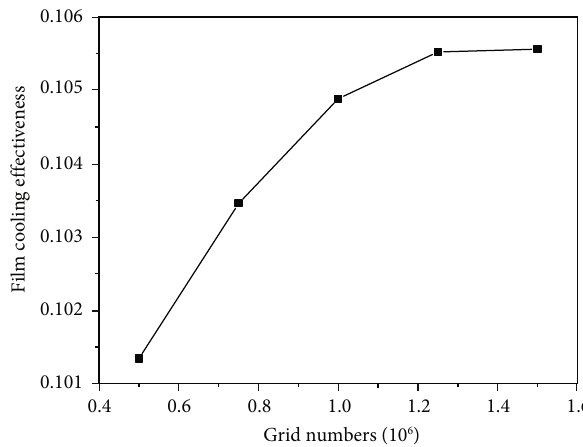
Figure 3: The fi lm cooling e ff ectiveness of the validation cases.